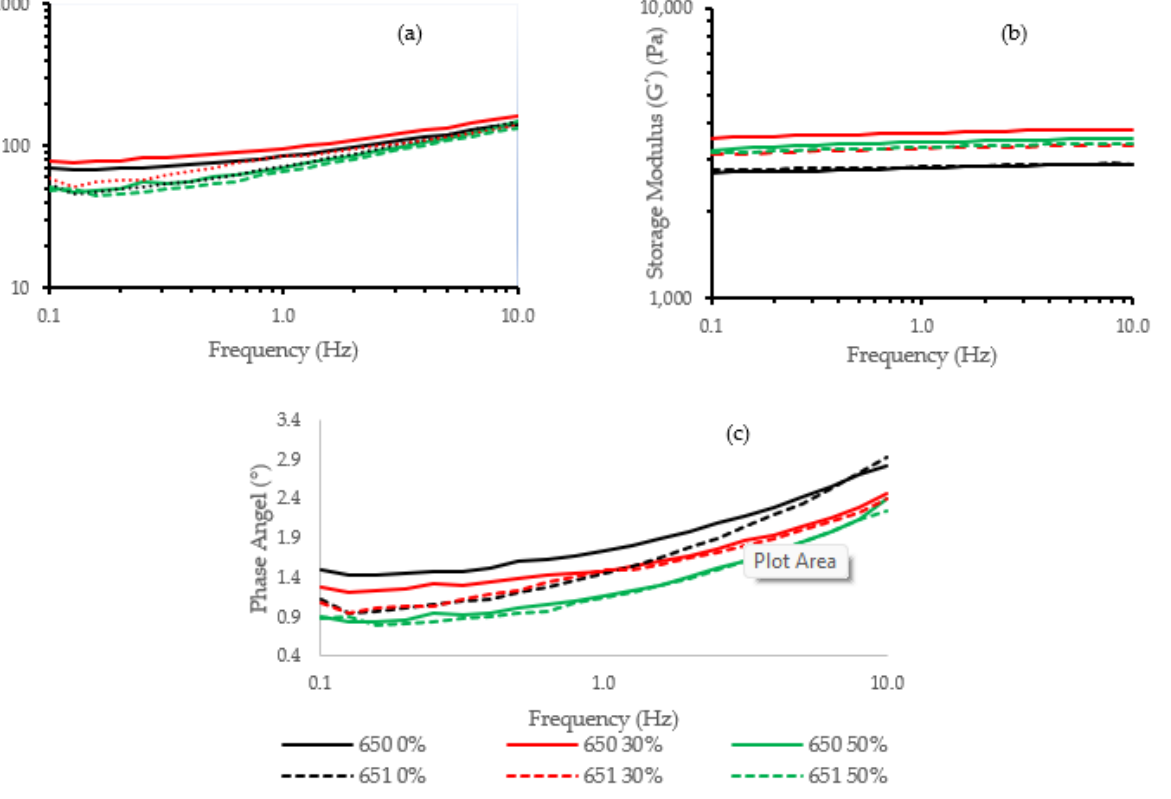
Figure 3. ( a ) Dynamic frequency sweep moduli ( G ’, G ”) and ( b ) phase angle of different cassava starch varieties (INIAP 650, INIAP 651) and ( c ) hydrolysis degree (0, 30,